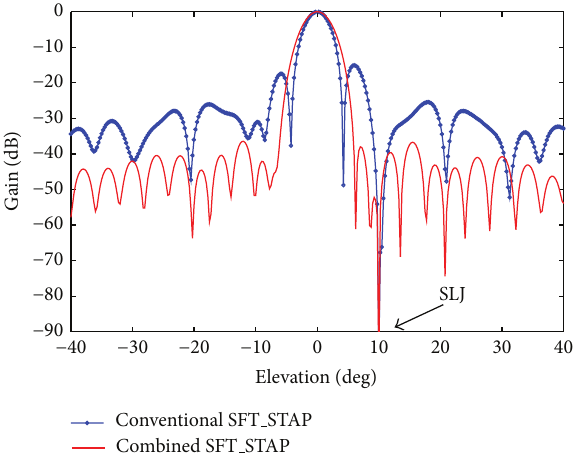
Figure6:Comparisonofcombinedsubarrayedfast-timeSTAPwith the optimum